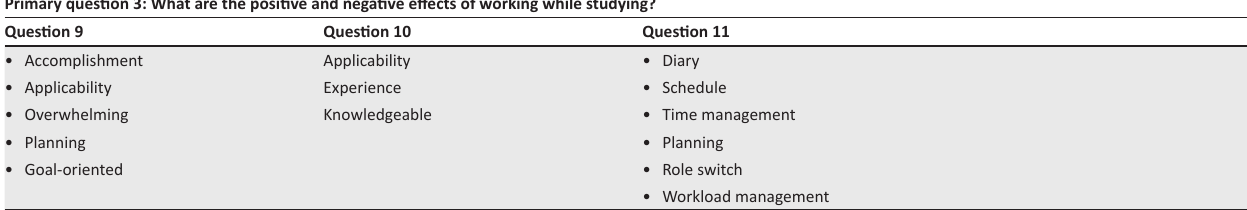
TABLE 2c: Interviewees’ coded responses.